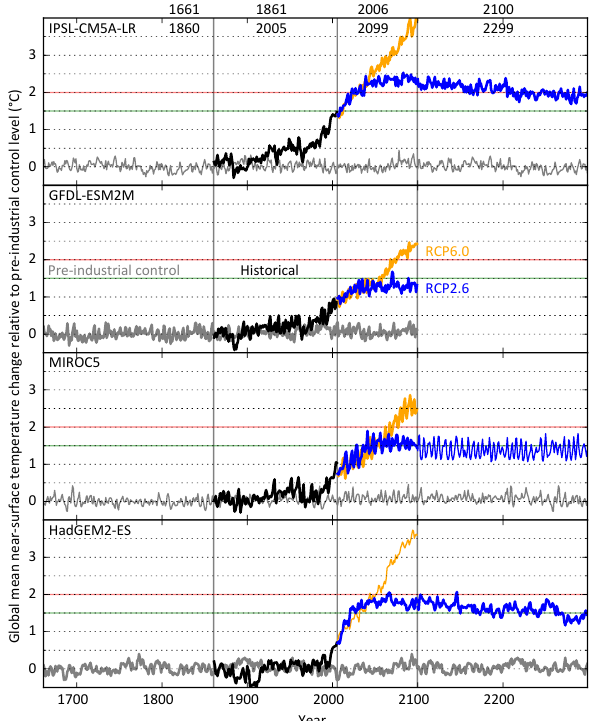
Figure 2. Time series of annual global mean near-surface tem- perature change relative to pre-industrial levels (1661–1860) as simulated with IPSL-CM5A-LR, GFDL-ESM2M, MIROC5 and HadGEM2-ES (from top to bottom). Colour coding indicates the underlying CMIP5 experiments (grey: pre-industrial control, black: historical, blue: RCP2.6, yellow: RCP6.0) with corresponding time periods given at the top. Thick lines indicate model–experiment combinations for which 3-hourly climate input data are available (see Table